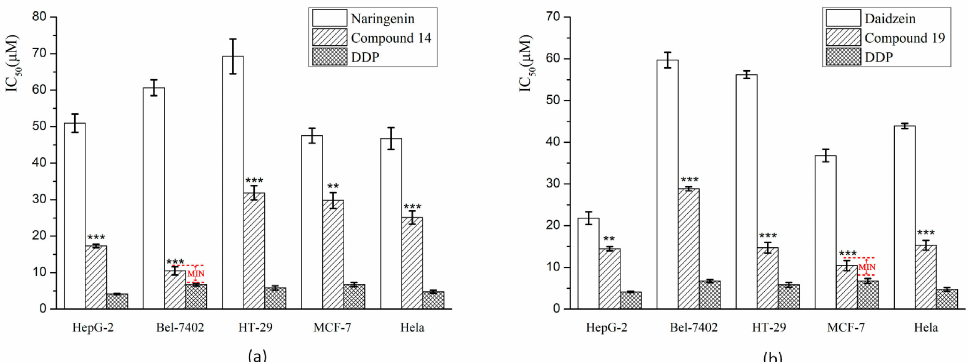
Figure 1. The IC 50 values against HepG-2, Bel-7402, HT-29, MCF-7, HeLa. ( a ) Naringenin, compound 14 , DDP. ( b ) Daidzein, compound 19 , DDP. ** p < 0.001, *** p < 0.001, vs. Naringenin, Daidzein. The red mark indicated that the IC 50 value of the compounds to the cells were closest to that of the DDP.